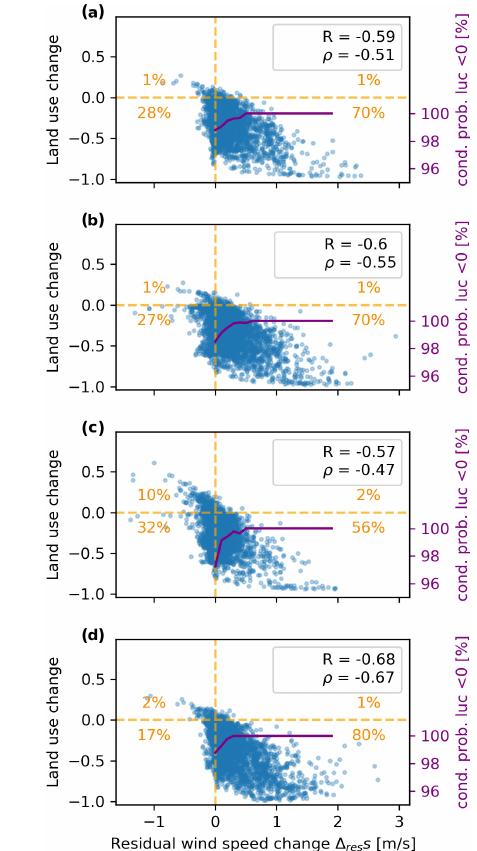
Figure 3. Scatterplots between changes in residual wind speeds and land use change over all locations with non-zero land use change (absolute value greater than 0.01). Each subplot denotes one sce- nario: historical (a) , rcp2.6 (b) , rcp4.5 (c) , rcp8.5 (d) . The secondary purple y axis shows the conditional probability of negative land use change given a wind speed change equal to or greater than the cor- responding value in the plot ( p (luc < 0 | (cid:49) res s > x ). Pearson corre- lation coefficient R and Spearman rank correlation ρ are given in the